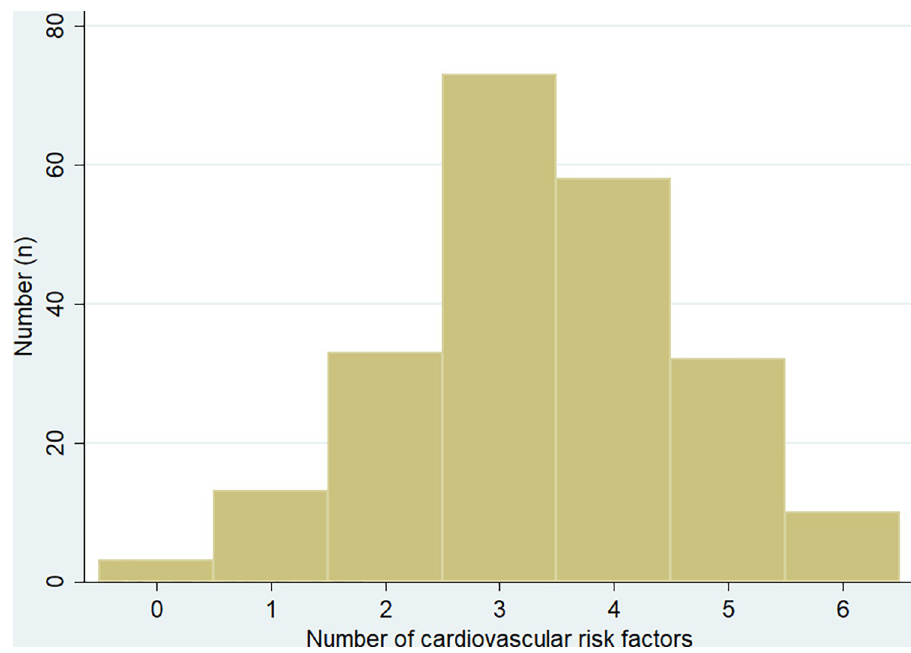
Fig 3. A histogram showing the number of modifiable risk factors for cardiovascular disease in each of the patients in the cohort.